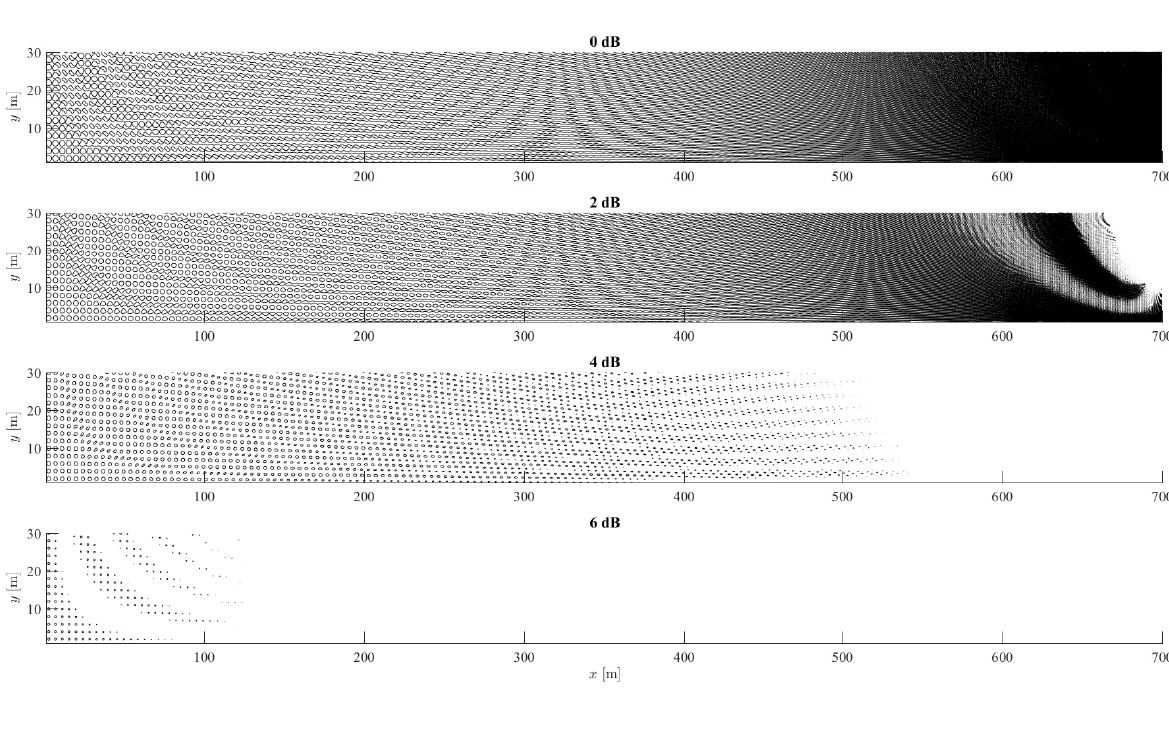
Figure 12: The same as Figure 10, but for semi-rigid walls, R h = R v = 0.5